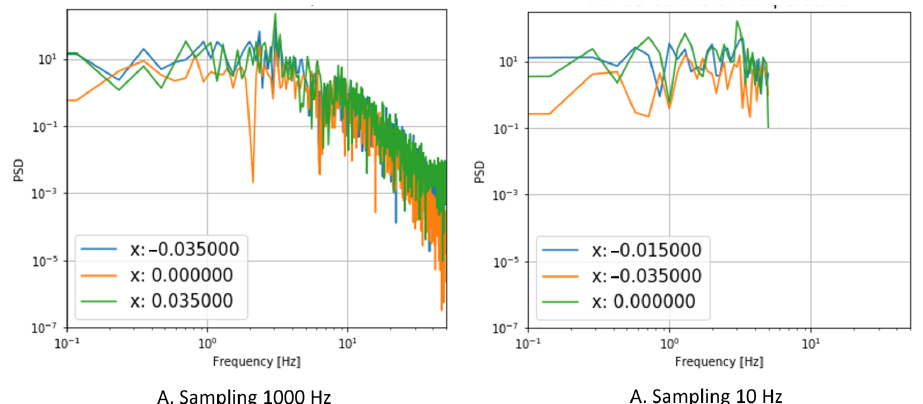
Figure 8. Temperature PSD curves calculated from the CFD data at three different x positions ( y = 0.09m; z = 0.1m), with two sampling